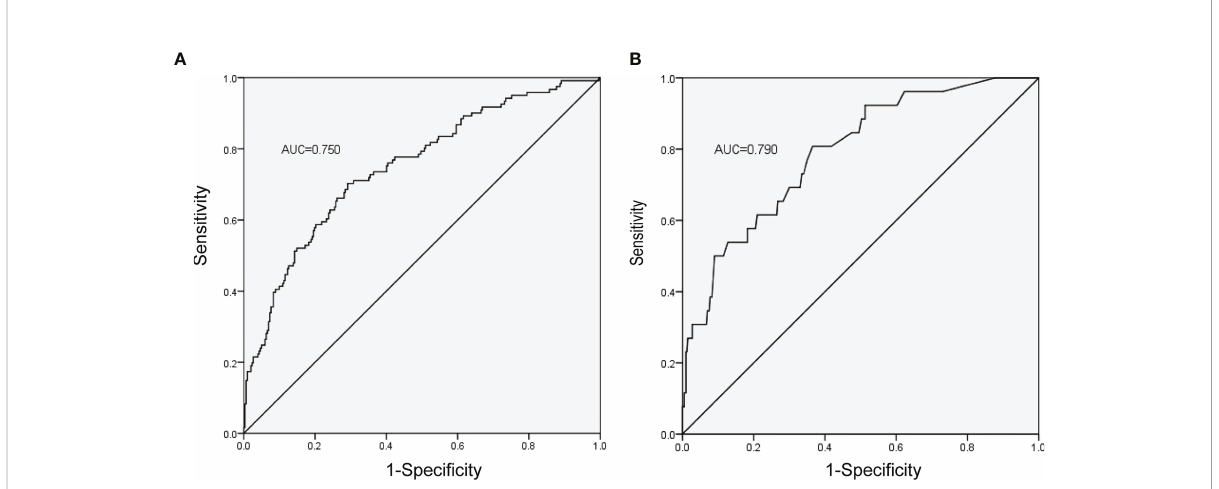
FIGURE 4 ROC curves of the nomograms with the training cohort. (A) Nomogram for prediction of overall complications. (B) Nomogram for prediction of severe complications.